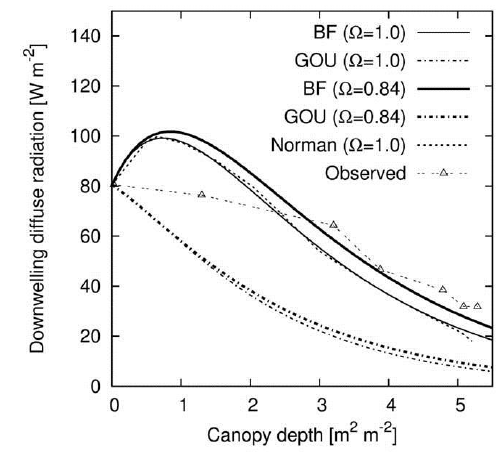
Fig. 3. Model efficiency (ME) was 0.46 and − 2.45 for the BF and Figure 3. Modeled downwelling diffuse radiation simulated using the BF model (solid lines) 2 GOU model respectively assuming no clumping; and − 2.06 and 0.63 respectively assuming a clumping index of (cid:127) = 0 . and GOU model (dotted/dashed lines) for leaves with random (Ω=1; thin lines) and clumped 3 distribution (Ω=0.84; thick lines). Leaf transmittance t =0.22 and fraction of diffuse to global 4 radiation fDif = 0.17. Measured data (open triangles) and model results using the Norman 5 model (dotted line) are extracted from Baldocchi et al. (Fig. 5: 1985). Model efficiency, 6 ME=0.46 and -2.45 for the BF and GOU model, respectively assuming Ω=1 and -2.06 and 7 0.63 respectively assuming Ω=0.84. 8